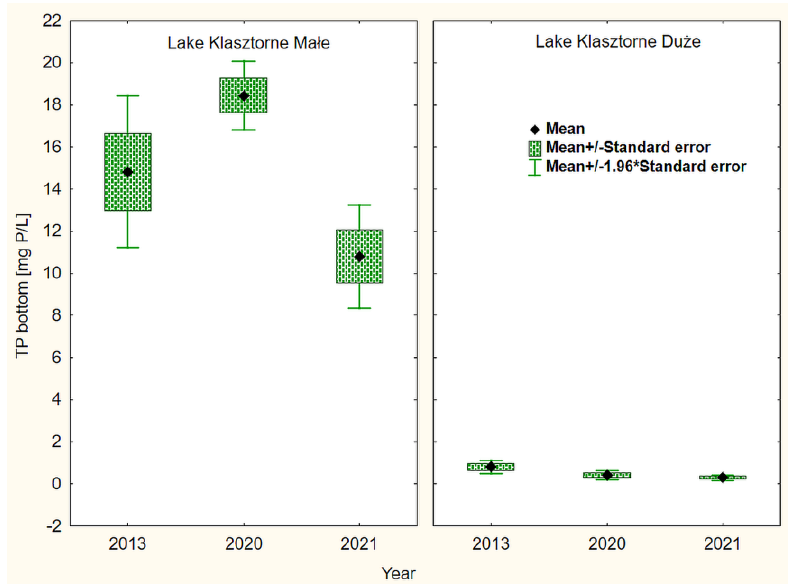
Figure 15. Average annual values of TP in the bottom water of the Klasztorne lakes in selected research years.